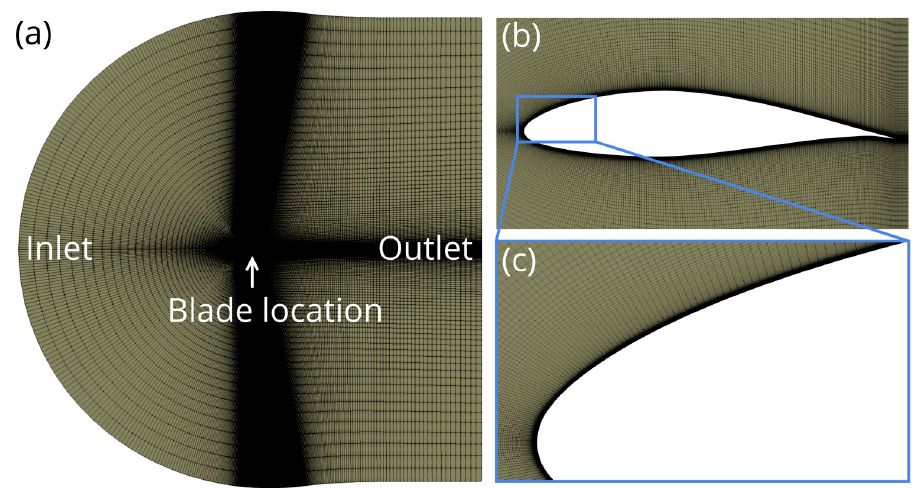
Fig 3. Computational mesh, which includes (a) the c-grid computational domain, (b) the near-blade mesh topology, and (c) the boundary layer mesh extrusion near the blade surface.